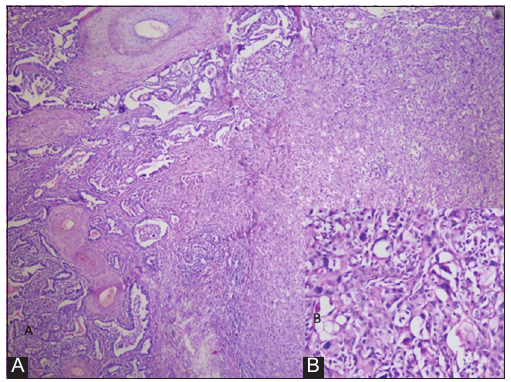
FIGURE 3. (A) Microscopically, the tumor had two components. The first component was a moderately differentiated adenocar - cinoma (left side of the image) and the second component were solid areas (right side of the image). (B) Microscopic examination of the hemorrhagic areas showed highly pleomorphic tumor cells and many syncytiotrophoblast-like cells with bizarre